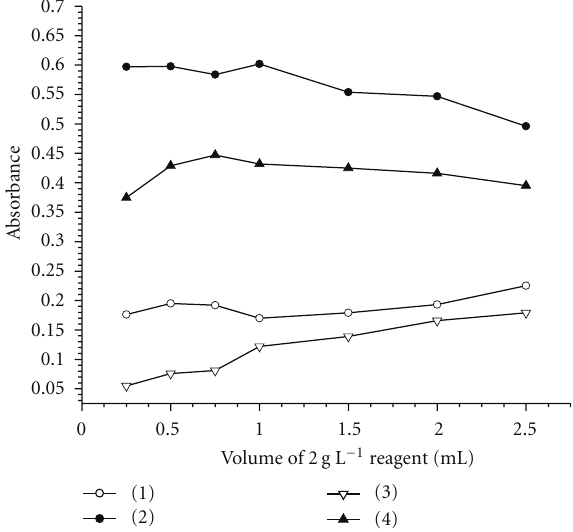
Figure 3: E ff ect of reagents concentrations on the color develop- ment: (1) corresponding blank-method A; (2) sample versus corre- sponding blank (8.0 μ gmL − 1 GBP)-method A; (3) corresponding blank-method B; (4) sample versus reagent blank (10.0 μ gmL − 1 GBP)-method